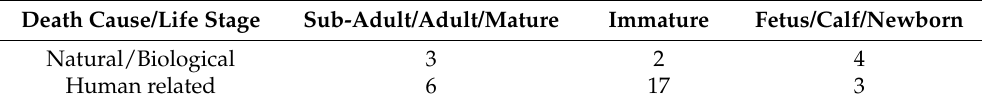
from r = 0.65 ( p < 0.0001) in the case of Index and log time to practical identity (r = 0.99; p < 0.0001) for Index and time. Table 3. Relative contingency table showing the expected increase in natural/biological causes of death for calves and a higher number of human related causes of death for immature animals. Death Cause/Life Stage Sub-Adult/Adult/Mature Immature Fetus/Calf/Newborn Natural/Biological 3 2 4 Human related 6 17